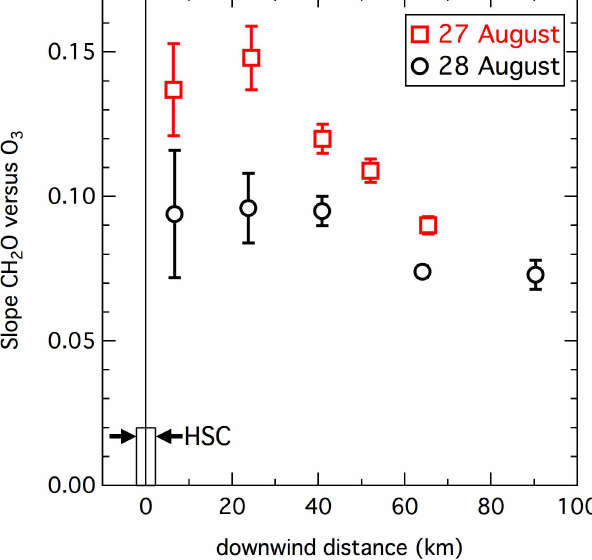
Fig. 2. Relationship of formaldehyde versus ozone mixing ratios measured during the 27 August 2000 flight. The data collected at one upwind (29.0 ◦ N latitude) and five downwind transects from HSC (east of − 95.5 ◦ longitude) are shown by different symbols color-coded according to latitude as indicated in the annotations. All other data are shown as grey dots. Linear least squares fits to the data from each transect are shown also color-coded. These fits all pass through the background mixing ratios of O 3 (31.7ppbv) and CH 2 O (0.5ppbv) as explained in text.